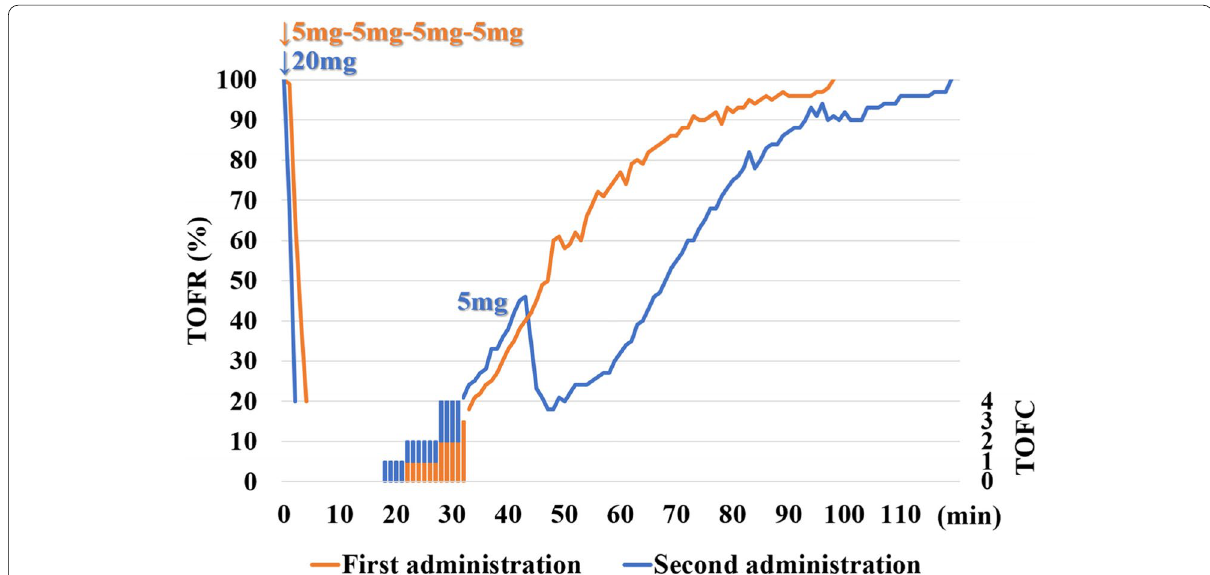
Fig. 1 Time course of train-of-four counts and its ratio after administration of rocuronium. Rocuronium 20 mg in four divided doses was administered before tracheal intubation (first administration, orange line), 20 mg bolus and additional 5 mg were administered during surgery (second administration, blue line). TOF: train-of-four, TOFR: train-of-four ratio, TOFC: train-of-four